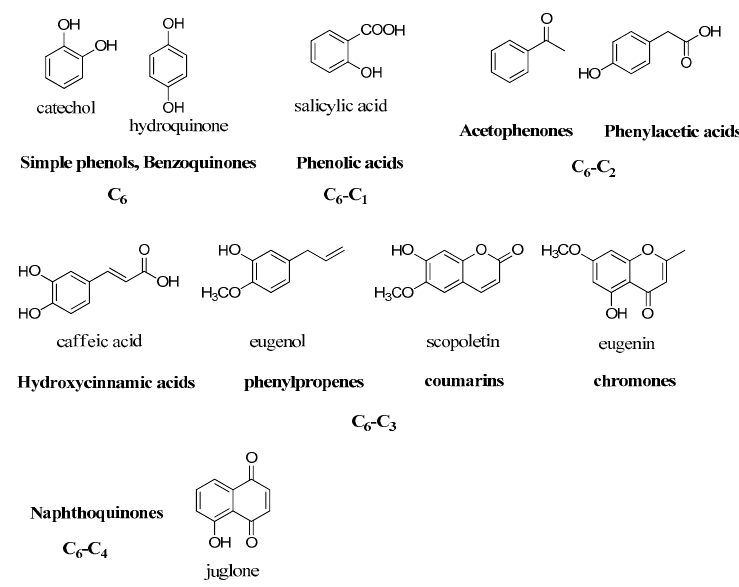
Figure 1. Main examples of phenols according to the classification of Harborne [32].